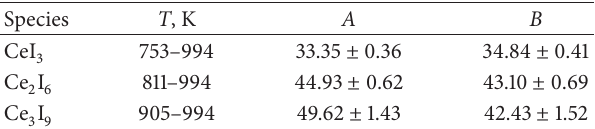
Table 2: Partial pressures (Pa) of the molecules. Table 3: Coefficients of (2).